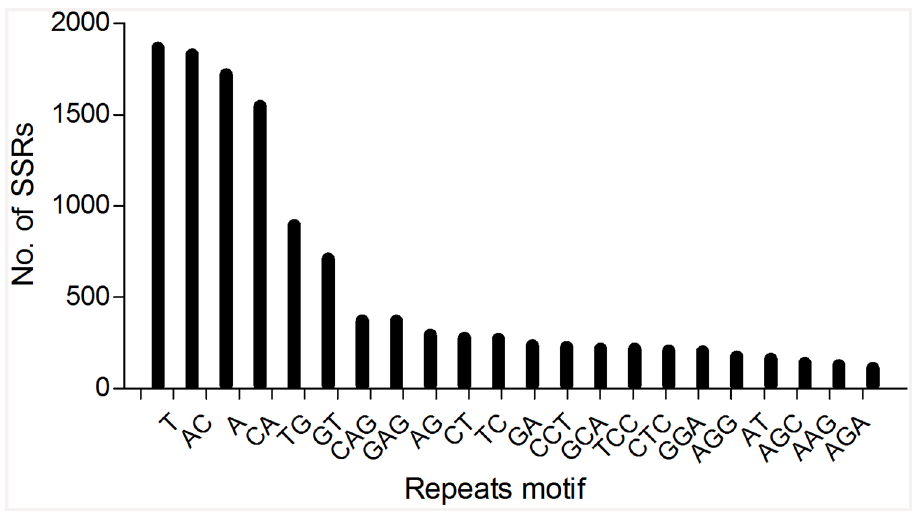
Fig 2. Summary of microsatellites repeat motifs and its richness across whole transcriptome of common coral trout.